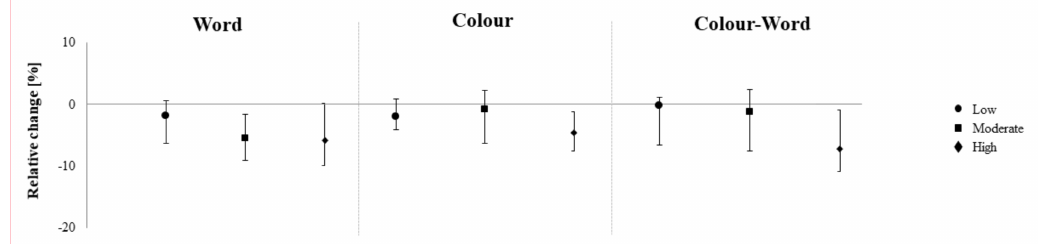
Figure 1. Pre-post di ff erences in the Trail Making test as a function of exercise intensity. Figure shows medians and parameter-free 95% confidence intervals.